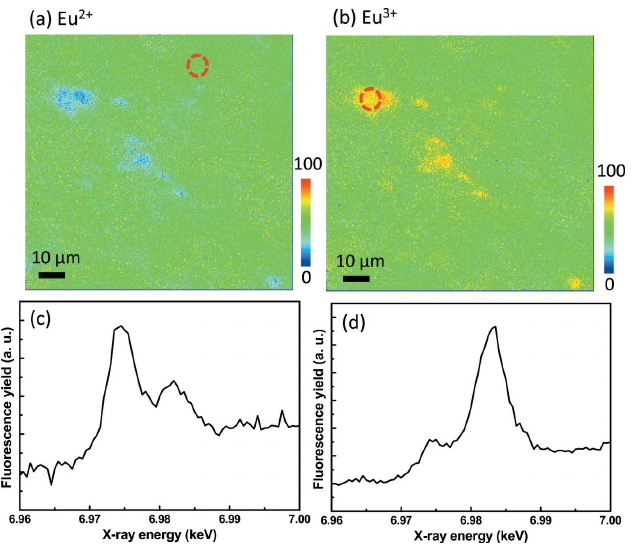
Figure 2 Estimation results for the distributions of ( a ) Eu 2+ and ( b ) Eu 3+ ions. Panels ( c ) and ( d ) show XAS spectra of the locations/areas marked with the red dashed circles in panels ( a ) and ( b ), respectively. The XAS spectra demonstrate the accuracy of the estimated results, implying that the valence states of the Eu ions can be easily and quickly visualized using XRF mapping.